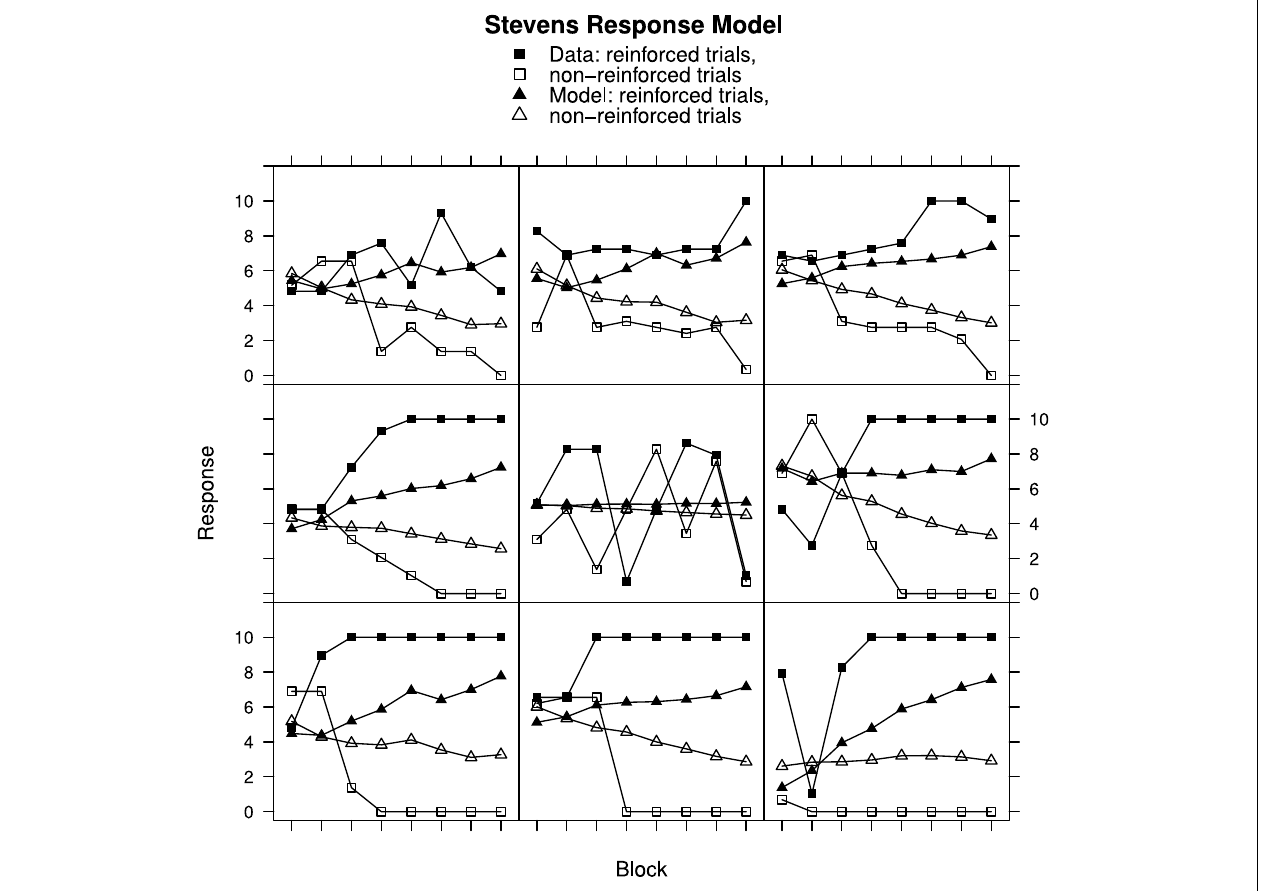
FIGURE 4 | RatingsandRescorla–WagnerModelpredictionsforreinforcedandnon-reinforcedtrialsusingtheStevensResponseModelinExperiment2. Top row , best fitting model samples. Middle row , intermediate fits. Bottom row , worst fitting model samples. See Results section on page 9 for further details.